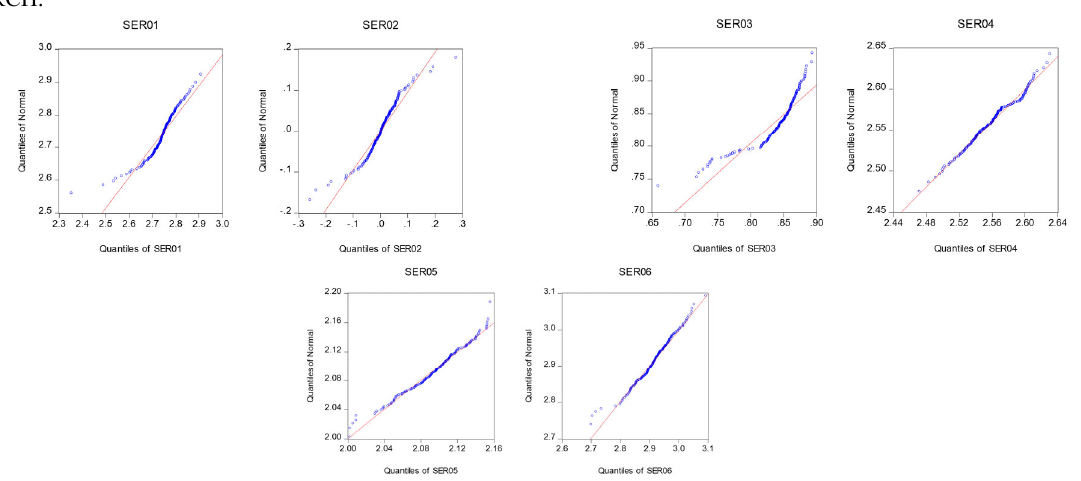
Fig. 1. Decrease of volatility spillovers in returns on Sharia Index stocks in